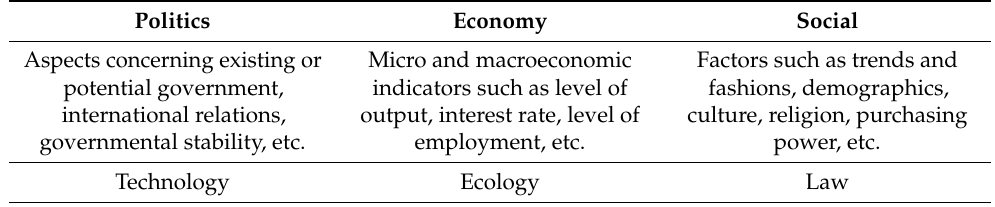
Table 2. Elements of